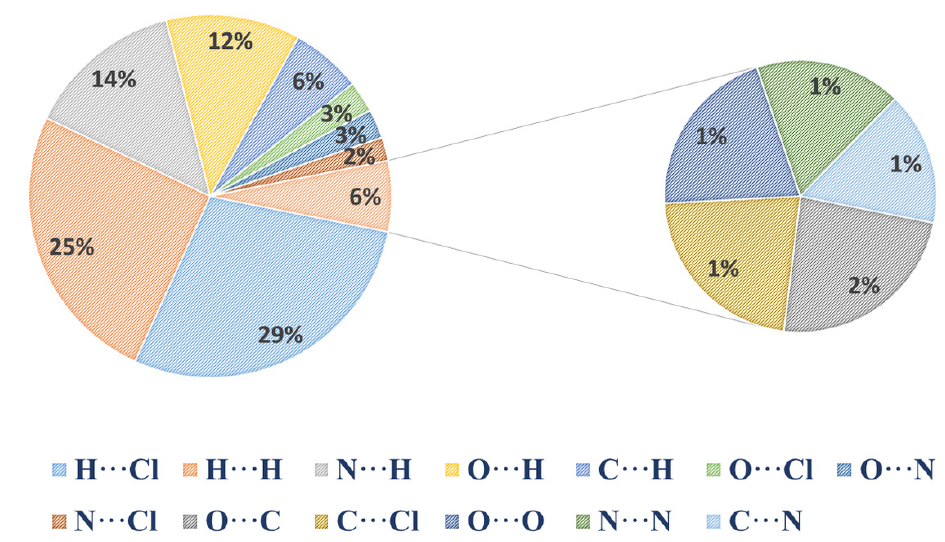
Figure 5. Histogram of different intermolecular contacts to the Hirshfeld surface area in (C 2 H 7 N 4 O) 2 BiCl 5 .